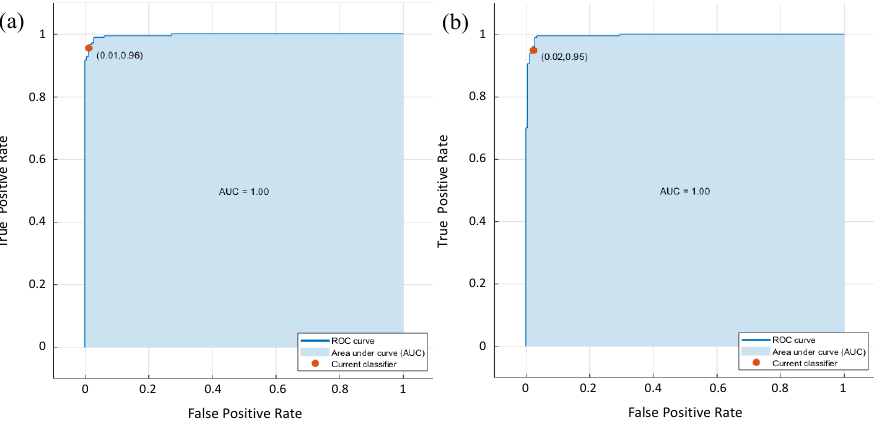
Figure 6. ROC curves and AUCs (the areas under ROC curves): ( a ) cubic SVM; ( b ) quadratic SVM.